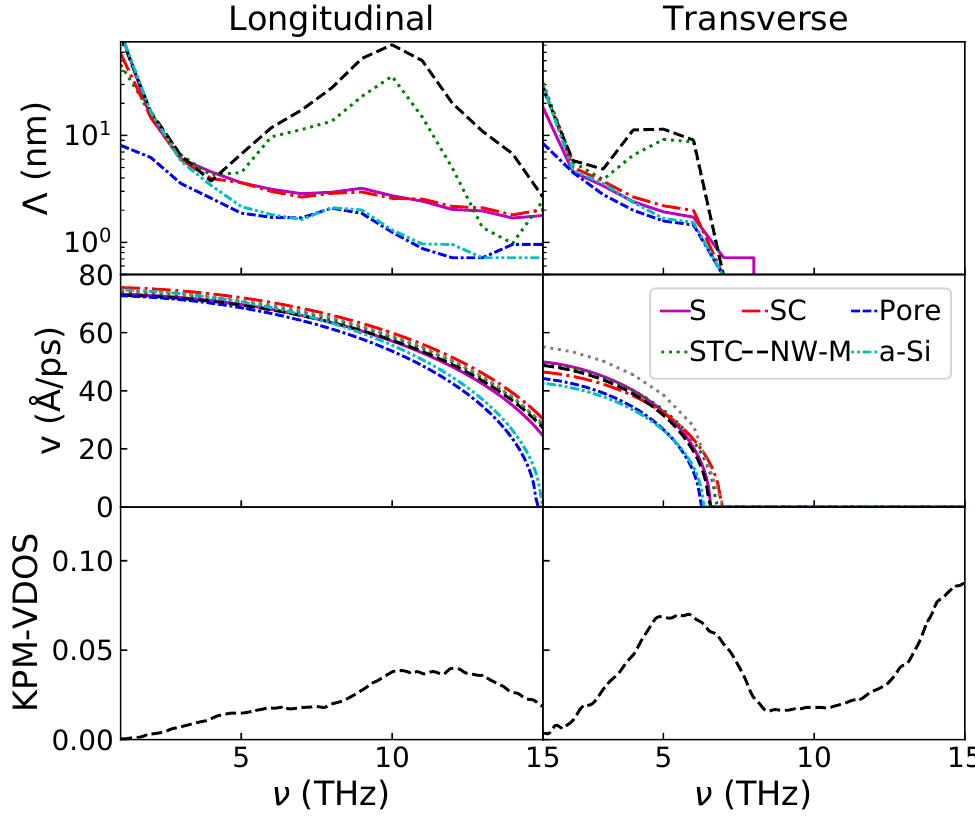
Figure 3. From right to left: First row, longitudinal and transverse mean free path; second row, longitudinal and transverse group velocity for the studied configurations; third row, longitudinal and transverse VDOS. Additionally, the group velocity computed for a fully crystalline sample is displayed with a dotted gray